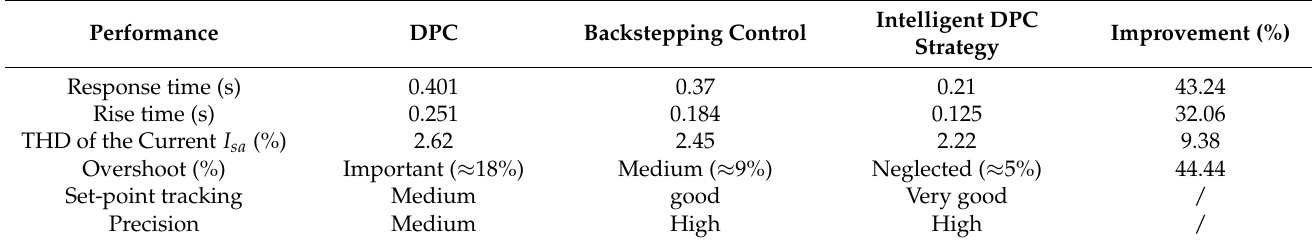
Table 4. Comparison between DPC, Backstepping control, and intelligent DPC strategy.